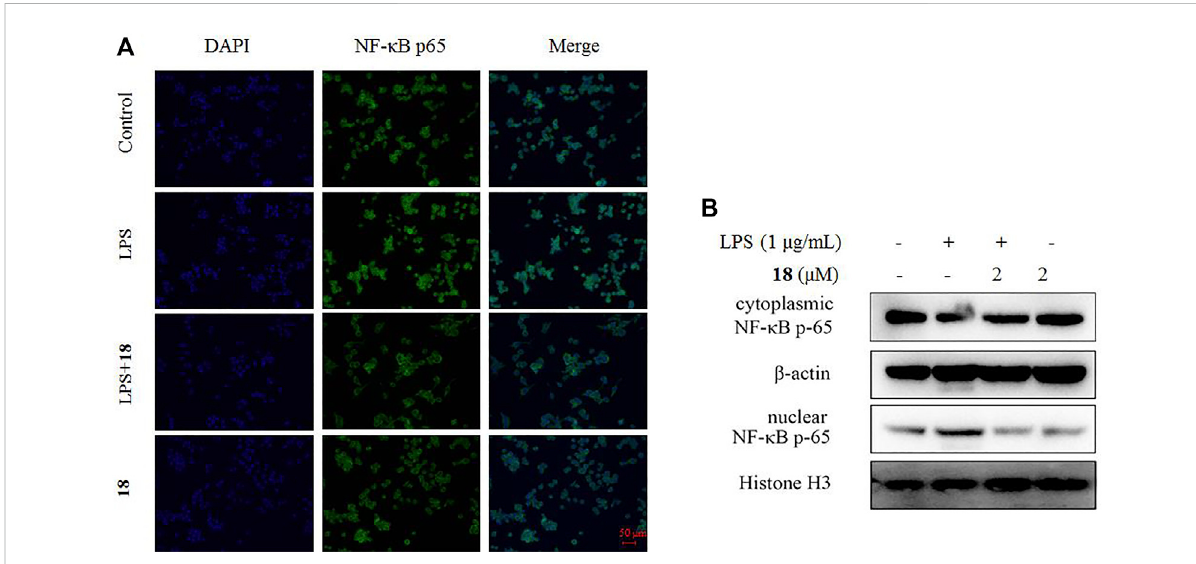
FIGURE 8 Effect of analog 18 on the nuclear translocation of NF- κ B p65 in LPS-stimulated BV-2 cells. (A) BV-2 cells were stimulated with LPS (1 μ g/ml) in theabsenceorpresenceofanalog 18 (2 μ M)for 3 h,followed bydetection oftheNF-kBp65subunittranslocationbyimmunocytochemistry. NF- κ B p65isshowningreen,andDNA(DAPInuclearstaining)isshowninblue.Bars:50 μ m. (B) BV-2cellswerestimulatedwithLPS(1 μ g/ml)intheabsence or presence of 18 (2 μ M) for 3 h, and NF-kB p65 levels in the nucleus and cytoplasm were determined by Western blot. Histone H3 and β -actin were used as endogenous controls for nuclear and cytoplasmic proteins, respectively. Values represent the mean ± SD of three independent experiments (*compared with the control, # compared with LPS, */ # p < 0.05, **/ ## p < 0.01, and *** p <